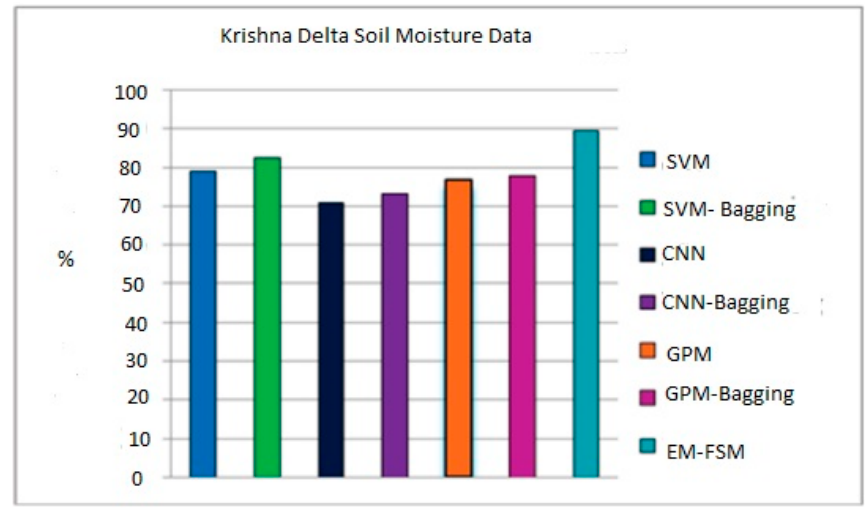
Figure 16. Prediction accuracy of di ff erent classi fi ers for the Godavari River plateau.